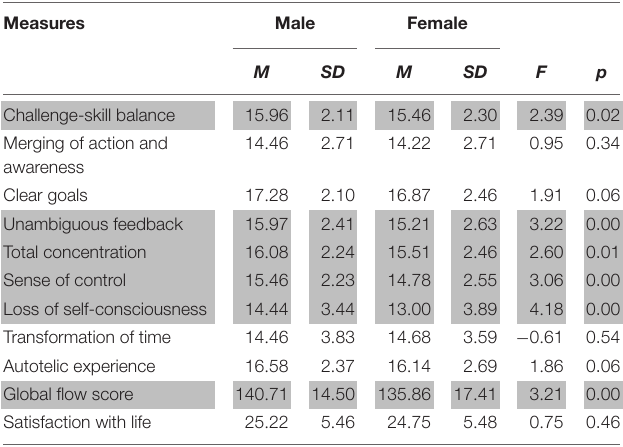
TABLE 4 | Comparison of male and female participants in flow dimensions and satisfaction with life. Measures